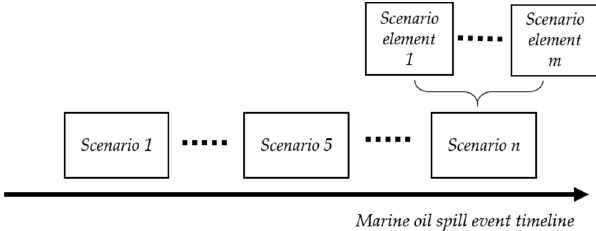
Figure 1. Hierarchical event–scenario instance–scenario element instance relationships .